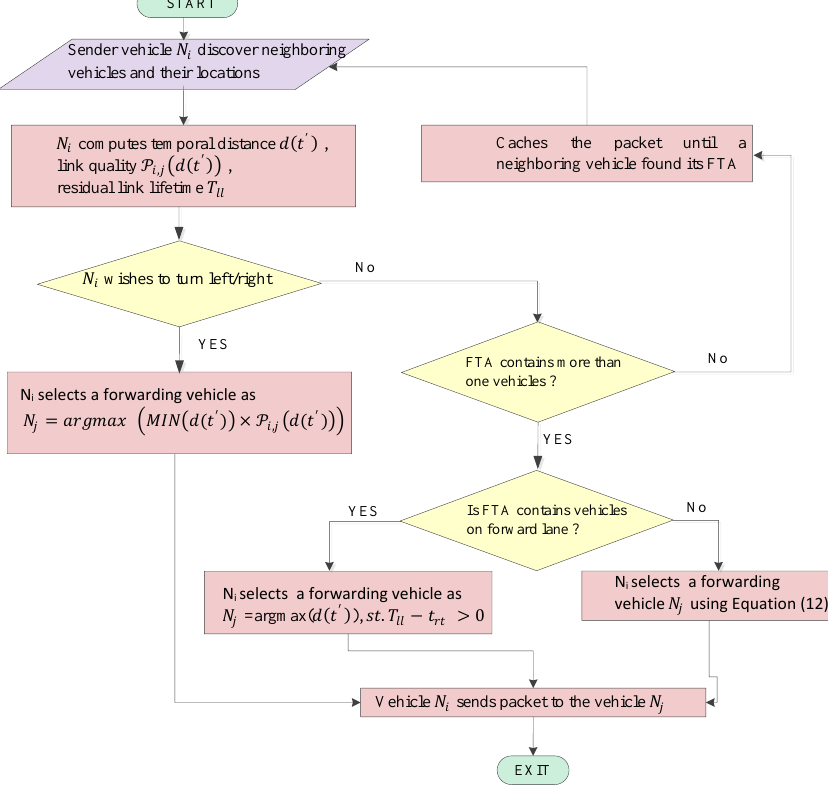
Figure 7. Flowchart of EGR.